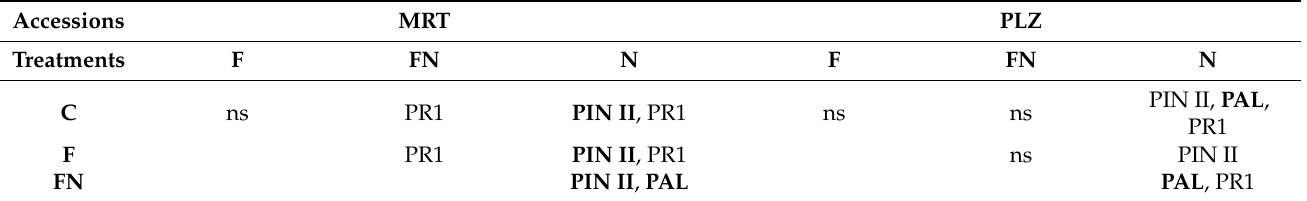
Table 3. Double entry table reporting significant gene expression response among the different treatments and accessions (upregulated genes are shown in bold; see Table 2 for description of treatments; LSD, Fisher test, p ≤ 0.05; ns = not